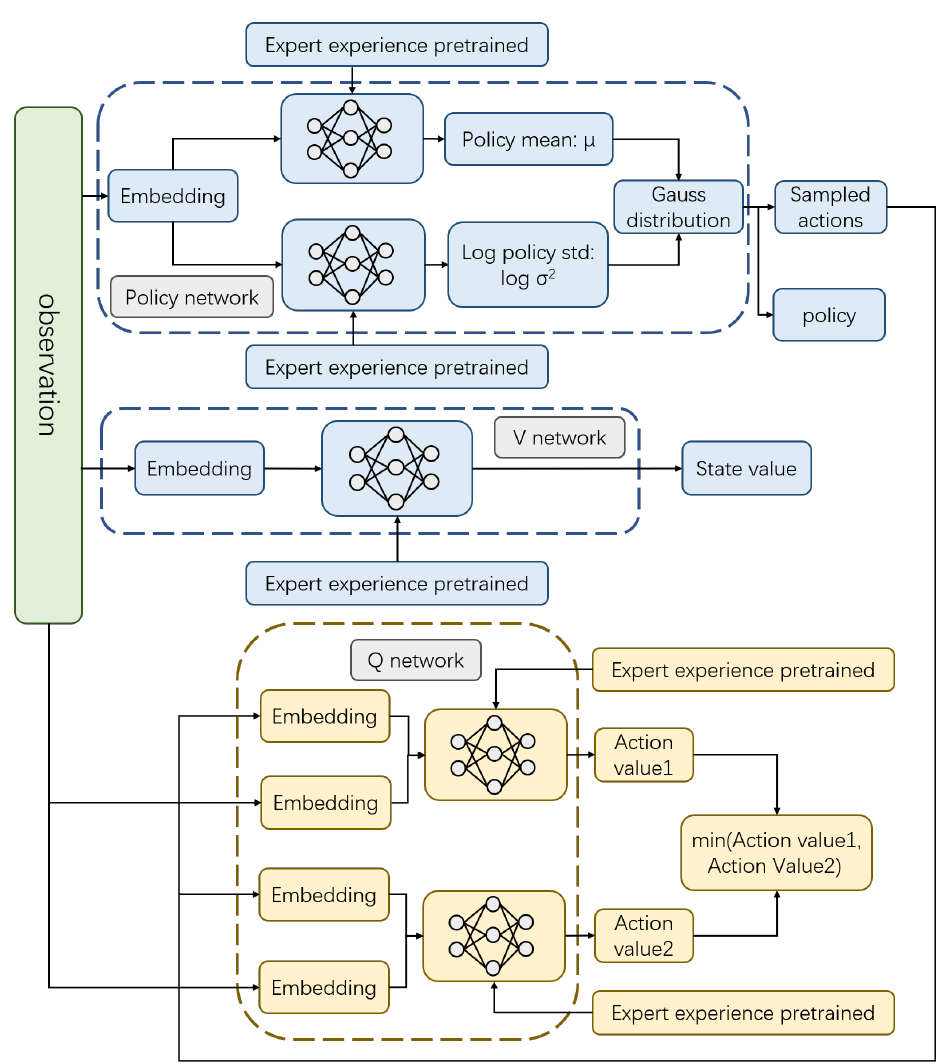
Figure 5. The training process of R-SAC algorithm.